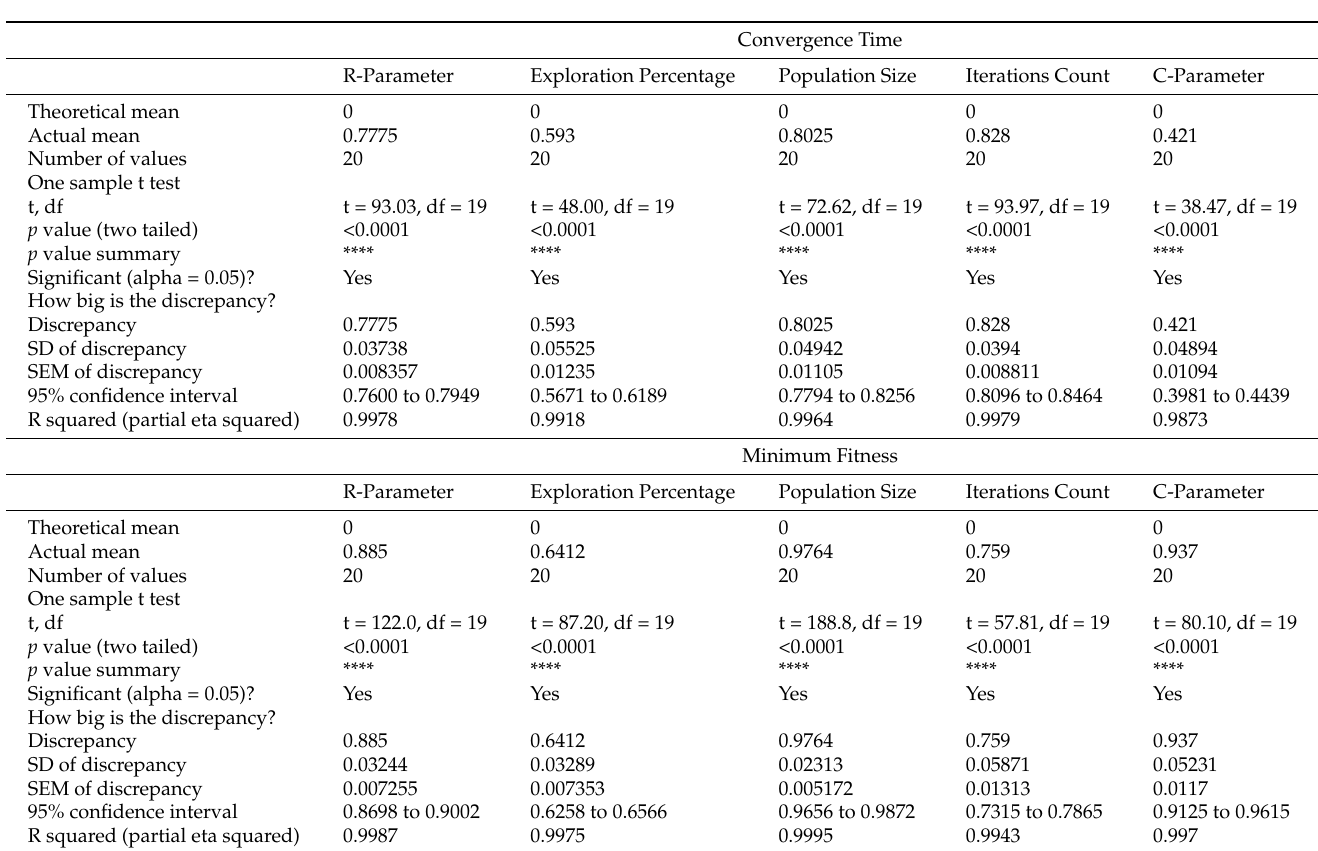
Table 19. T-test with one tail was run at a significance level of 0.05 for different values of the GSDTO’s